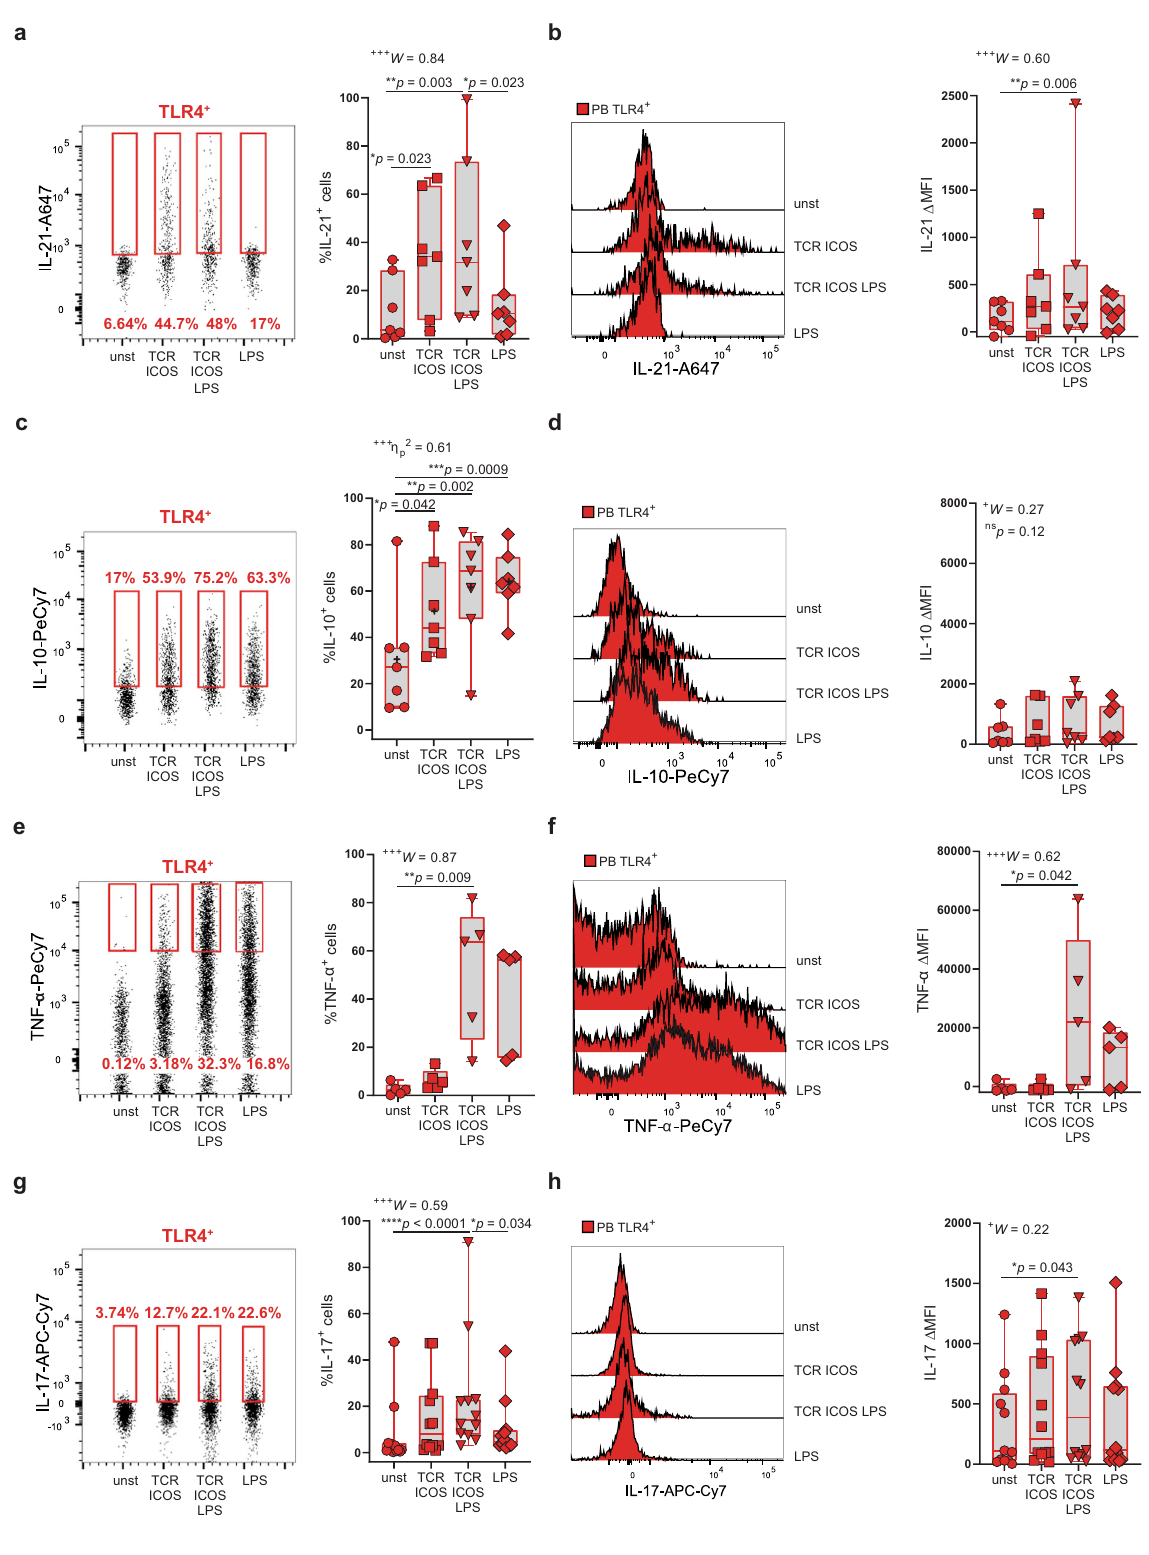
show that TCR stimulation drives TLR4 and CD14 expression in CD4 + T cells from HDs and RA patients, we favor the view that HLA-DR:TCR interactions between neighboring T cells under- pins TLR4 upregulation. Non-cognate HLA-DR:TCR interactions between APCs and T cells are known to alter T-cell genetic pro fi le 60,61 . Thus, it is possible that T-T-cell interactions through non-cognate HLA-DR:TCR contacts might drive TLR4